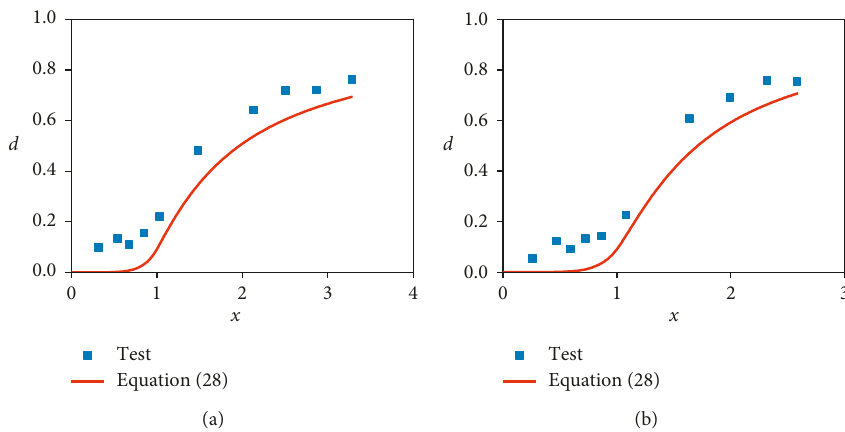
Figure 15: Damage evolution of the RAC obtained from reference [34]. (a) RAC-50 ( r � 50%). (b) RAC-100 ( r �